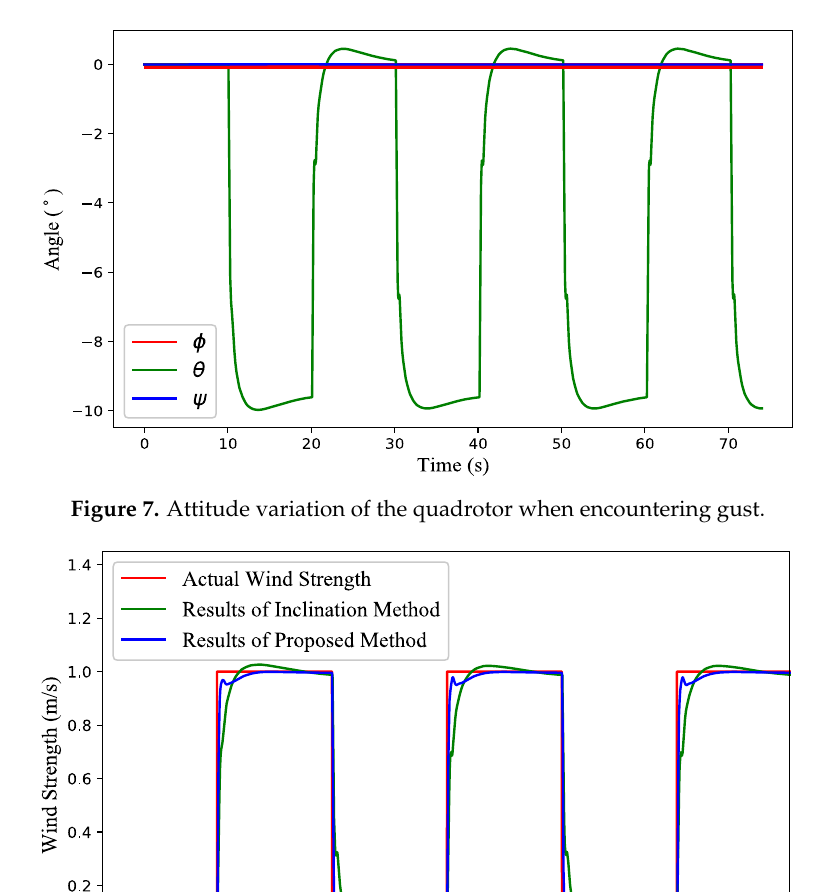
Table 3. RMSEs of the estimated wind velocities.